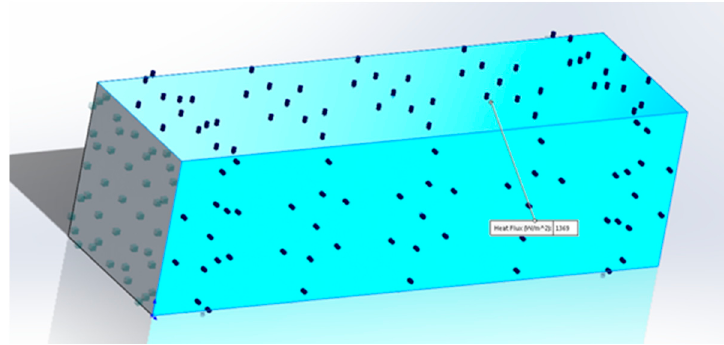
Figure 51. Applied Solar Flux Loads.